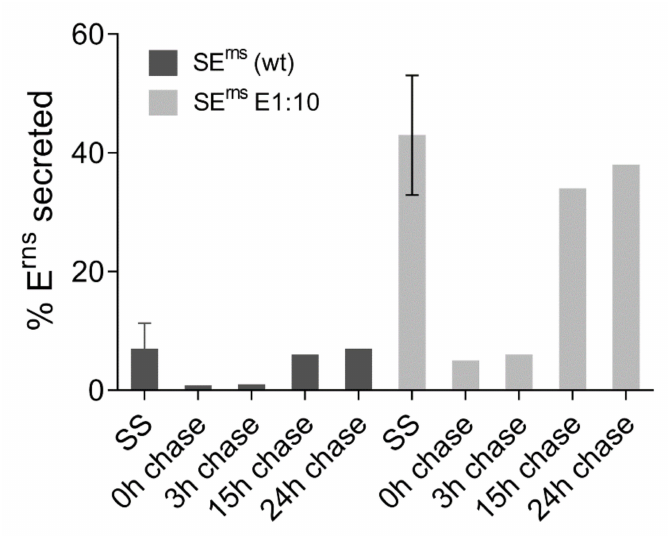
Figure 9. Pulse/chase analysis of E rns secretion. The diagram summarizes the results of pulse chase studies comparing the secretion of wt E rns (SE rns ) and the super-secretion mutant SE rns E1:10 over time. The bars represent the amount of secreted protein as percent of total recovered E rns . The counts determined for extra- and intracellular E rns quantified via phosphorimager analysis were set to 100% expression product as basis for calculation of the secretion value. At the X-axis the information on the samples is given with SS standing for steady state (26 h labelling) and for the other samples the time of chase following a 2 h pulse labelling